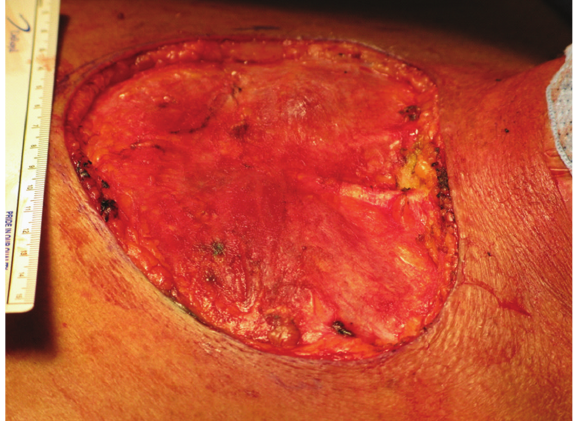
Figure 2: Surgical defect measuring 145cm 2 .